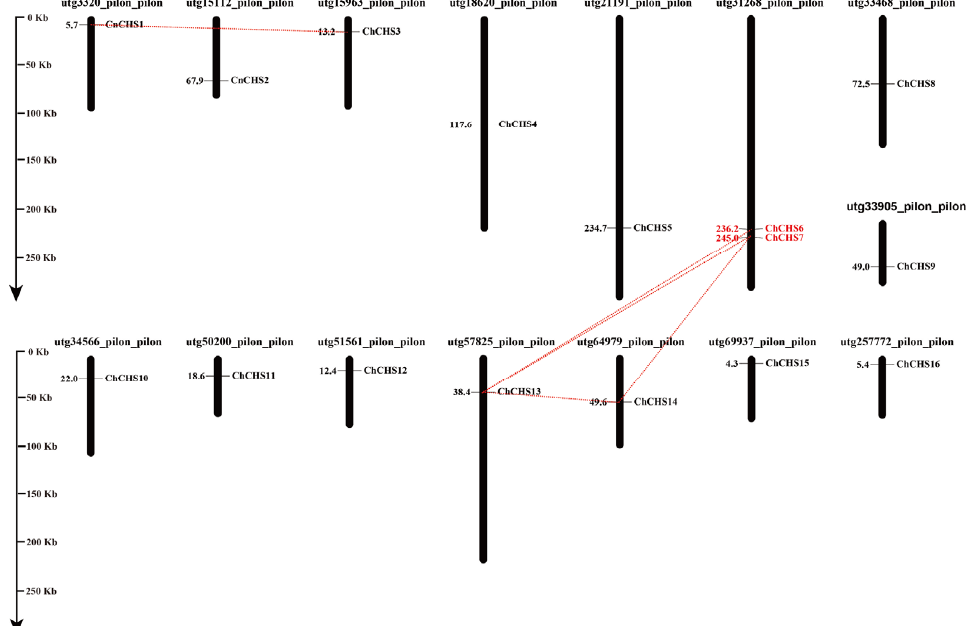
Figure 4. Location of 16 CnCHS genes on chrysanthemum scaffolds. The segmental duplicated genes are connected by red dashed lines, and the tandemly repeated genes are marked in red.